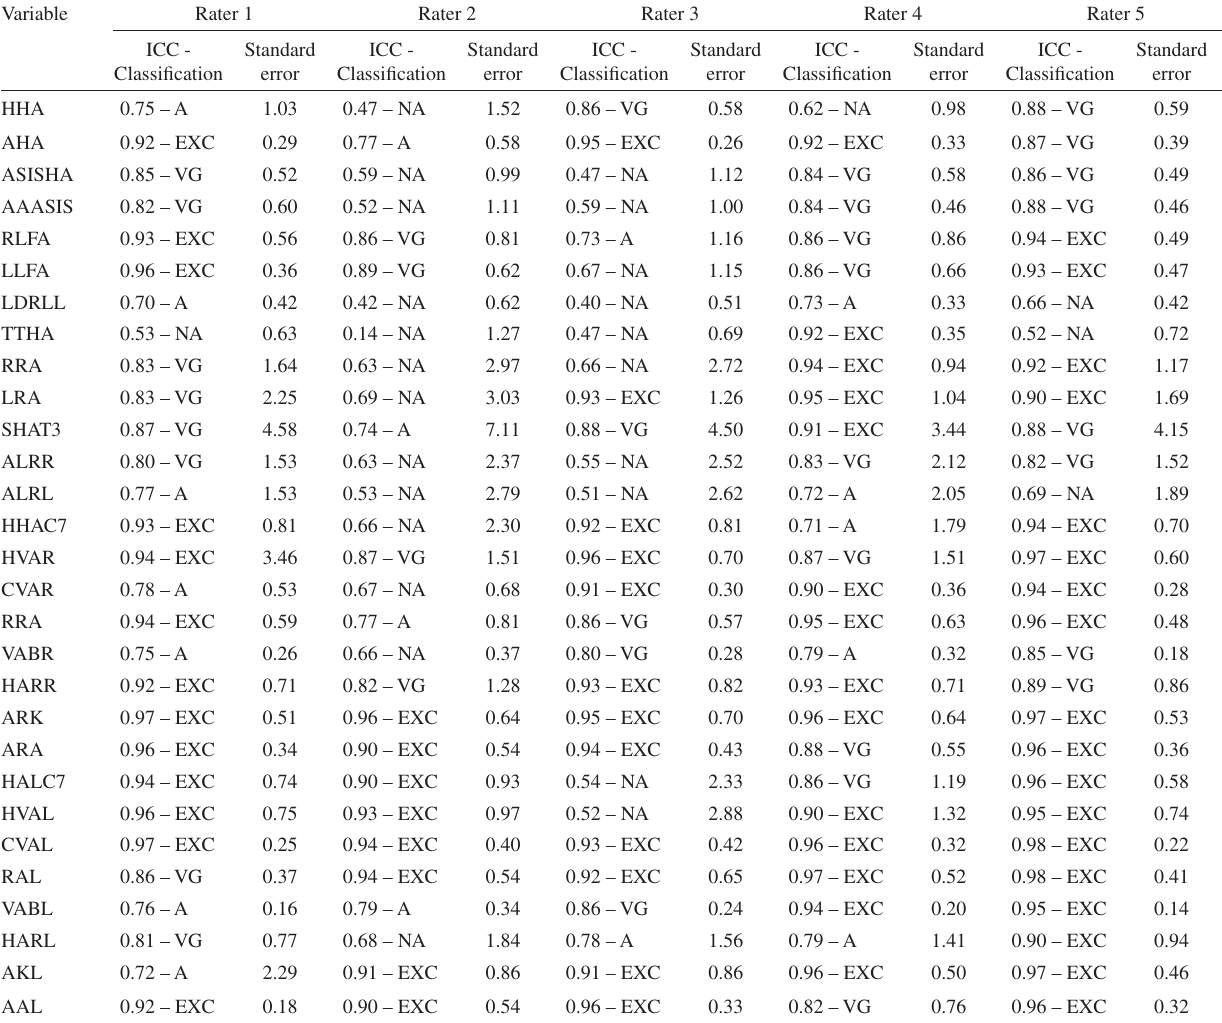
Table 2 - Intra-rater reliability: standard error, ICC, and classification for repetitive measurements using the PAS/SAPO. Variable